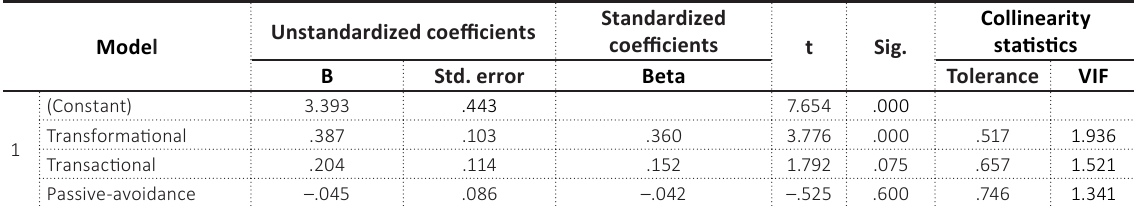
Table 5. Regressions coefficients (leadership styles and work engagement)